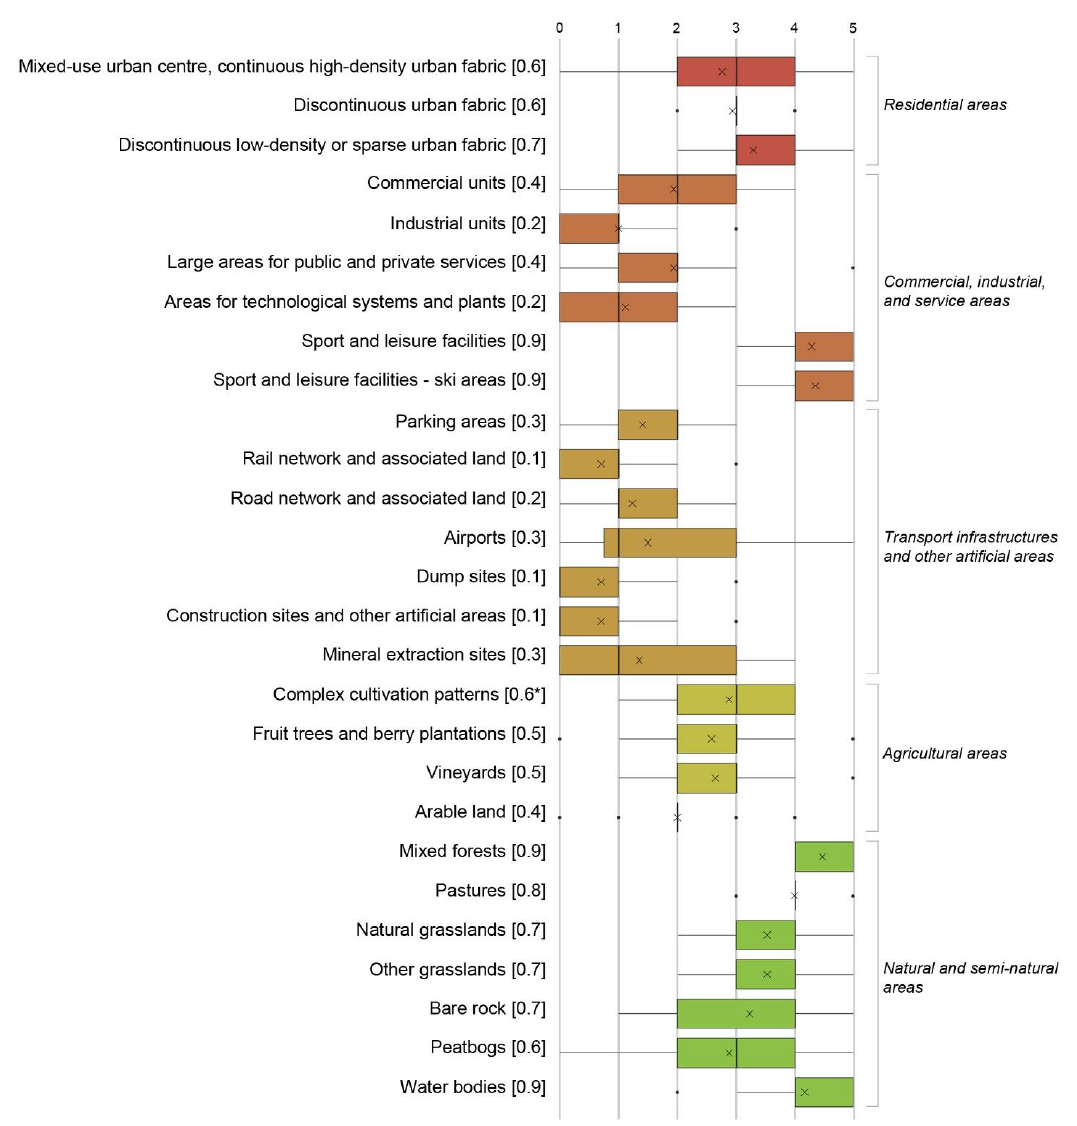
Figure 3. Box-plots showing the distribution of the scores assigned to the different land use classes by local experts. In square brackets are the final normalized scores used to run the model. Colors identify main categories of land uses. * A score of 0.7 was assigned to community gardens. Map data retrieved from the Land Use Map of the city of Trento [45].